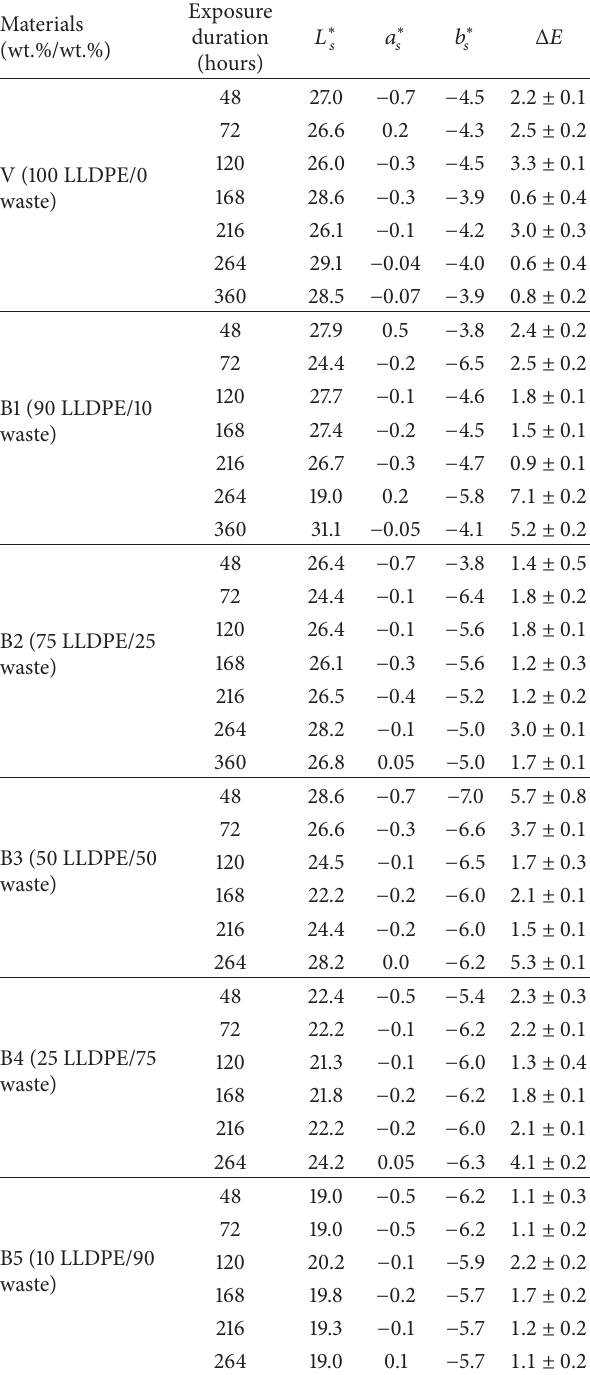
Table 1: Control samples (no exposure) colour parameters. Table 2: Colour parameters and total change in colour ( Δ𝐸 ) for studied formulations at different accelerated weathering exposure (hours) processed at a DHT = 175 ∘